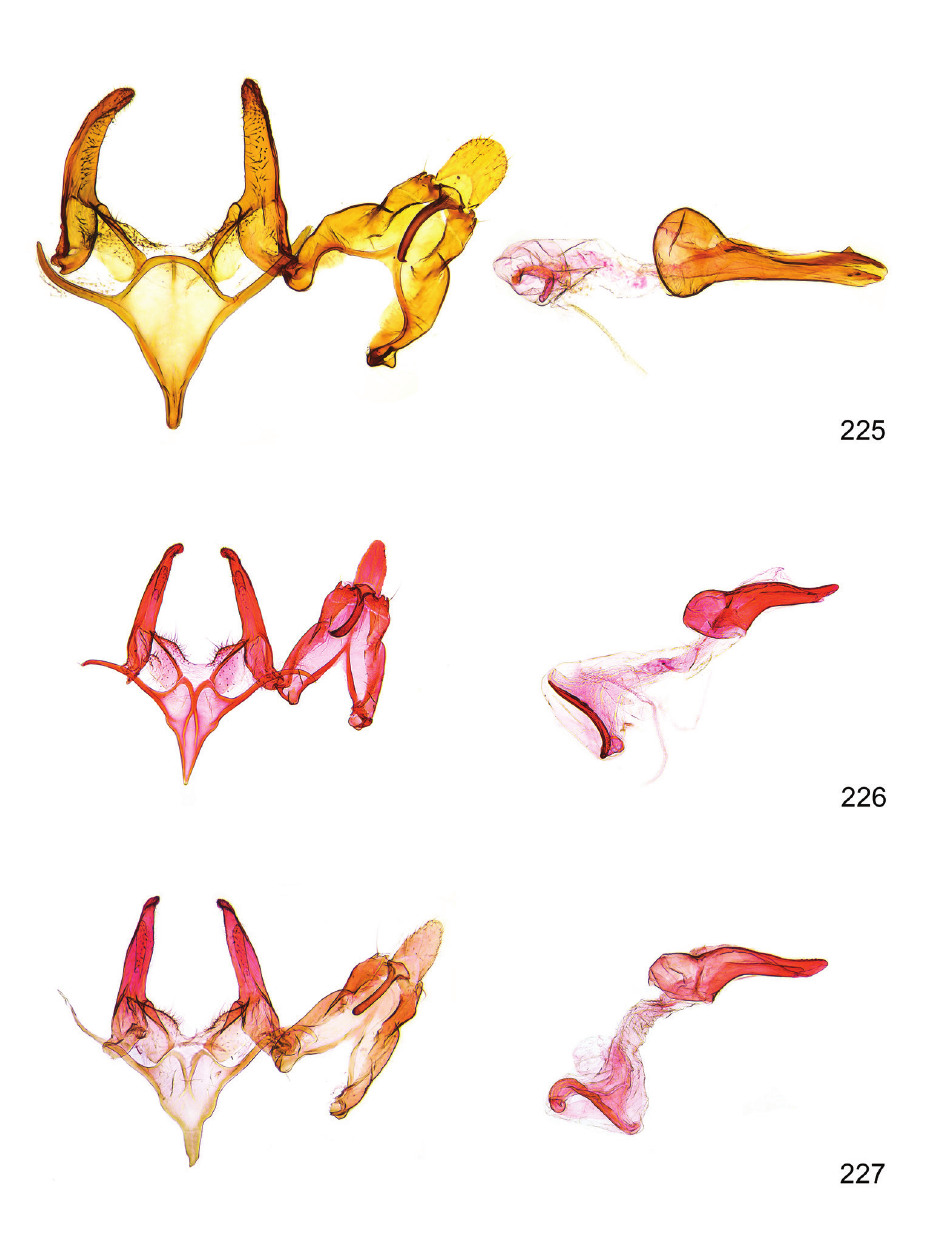
Figures 225–227. Megacraspedus male genitalia. 225 M. tenuignathos sp. n. – Holotype, Morocco, GU 16/1423 P.H. (RCAW) 226 M. glaberipalpus sp. n. – Paratype, Morocco, GEL 1245 P.H. (TLMF) 227 M. glaberipalpus sp. n. – Paratype, Morocco, gen. slide 16.665